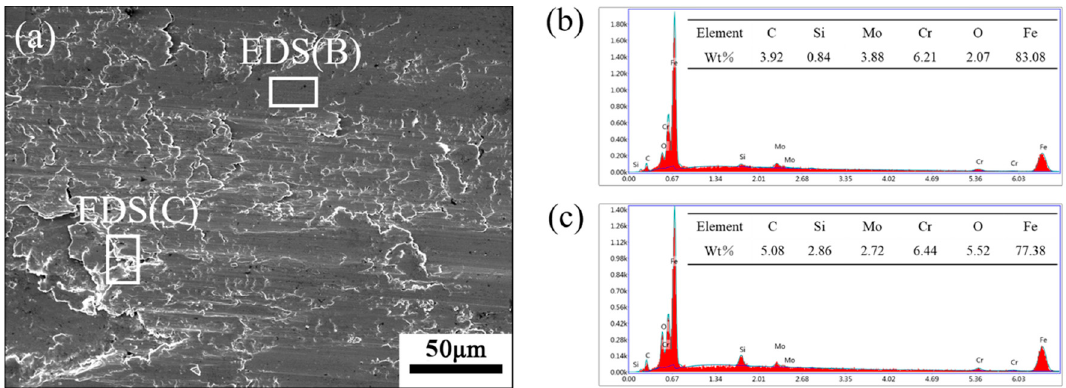
Figure 4. Surface wear morphology and EDS analysis of 680°C tempered samples after 15 min wear. ( a ) Micro morphology of worn surface; ( b ) EDS analysis of region marked with EDS(B); ( c ) EDS analysis of region marked with EDS(C).